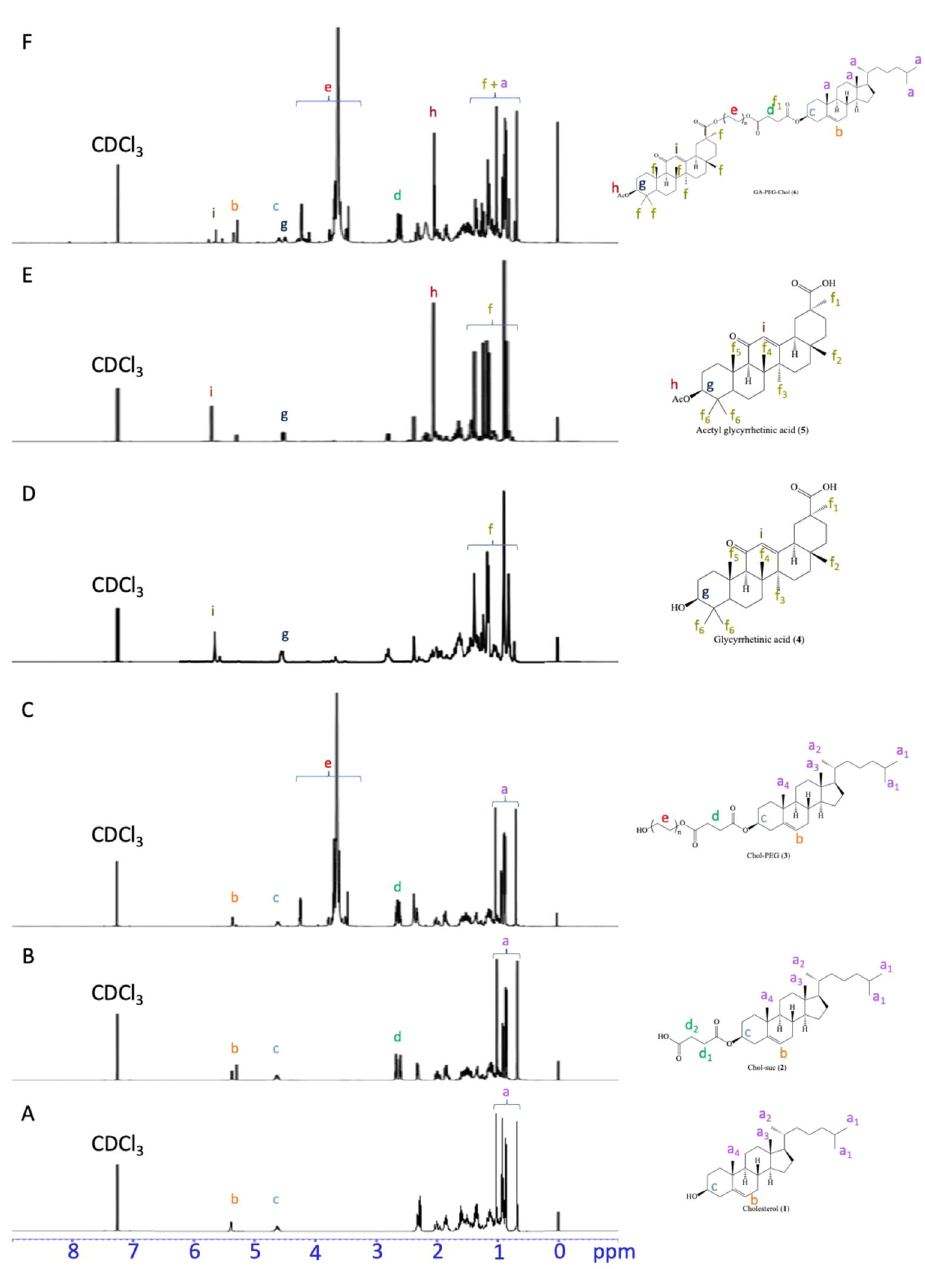
Fig. 2 The 1 H NMR spectra of ( A ) Cholesterol ( 1 ), ( B ) Chol- suc ( 2 ), ( C ) Chol-PEG ( 3 ), ( D ) GA ( 4 ), ( E ) acetyl glycyrrhetinic acid ( 5 ), and (F) GA-PEG-Chol ( 6